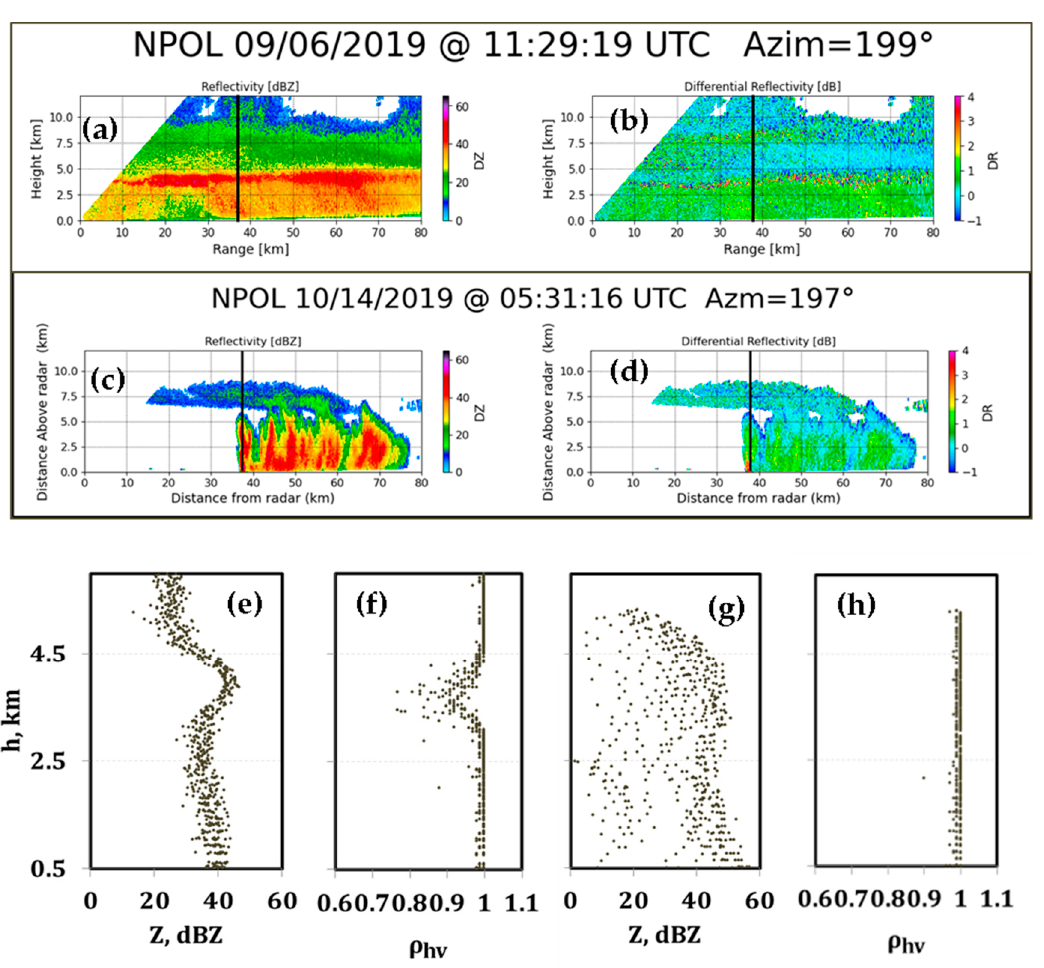
Figure 3. ( a ) RHI scan of Z h and ( b ) Z dr during a stratiform rain event on 6 September 2019 (Rain bands of Dorian storm). ( c , d ) RHI scans of Z h and Z dr during another convective rain event on 14 October 2019. ( e , f ) Vertical profiles of Z h and ρ hv respectively, over the disdrometers for the stratiform rain in case ( a ), and ( g , h ) vertical profiles of Z h and ρ hv respectively, over the disdrometers for the convective event in case ( c ).